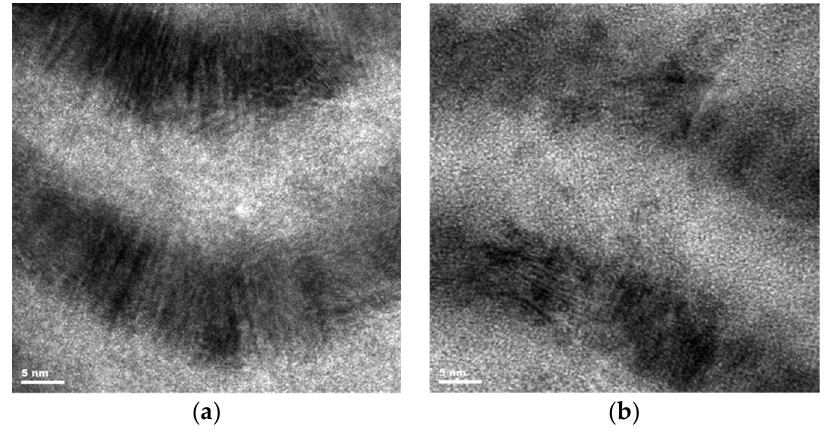
Figure 8. HRTEM images of the Al/Ni (V) films with  = 25 nm: ( a ) V S = −80 V (ion gun off); ( b ) ion